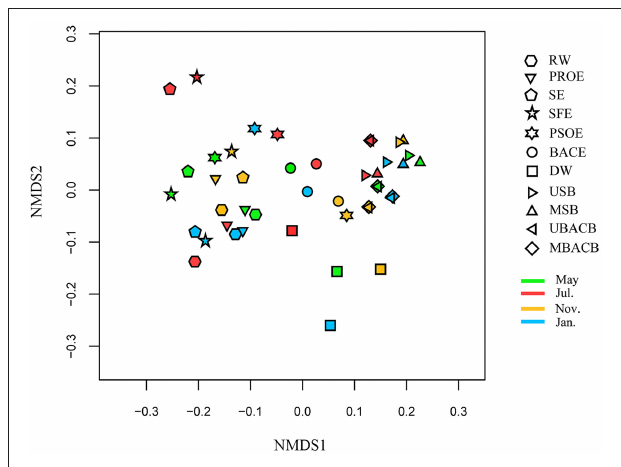
FIGURE 7 | NMDS analysis based on predictive functional genes. The abbreviations of the samples are the same as used in Table 2